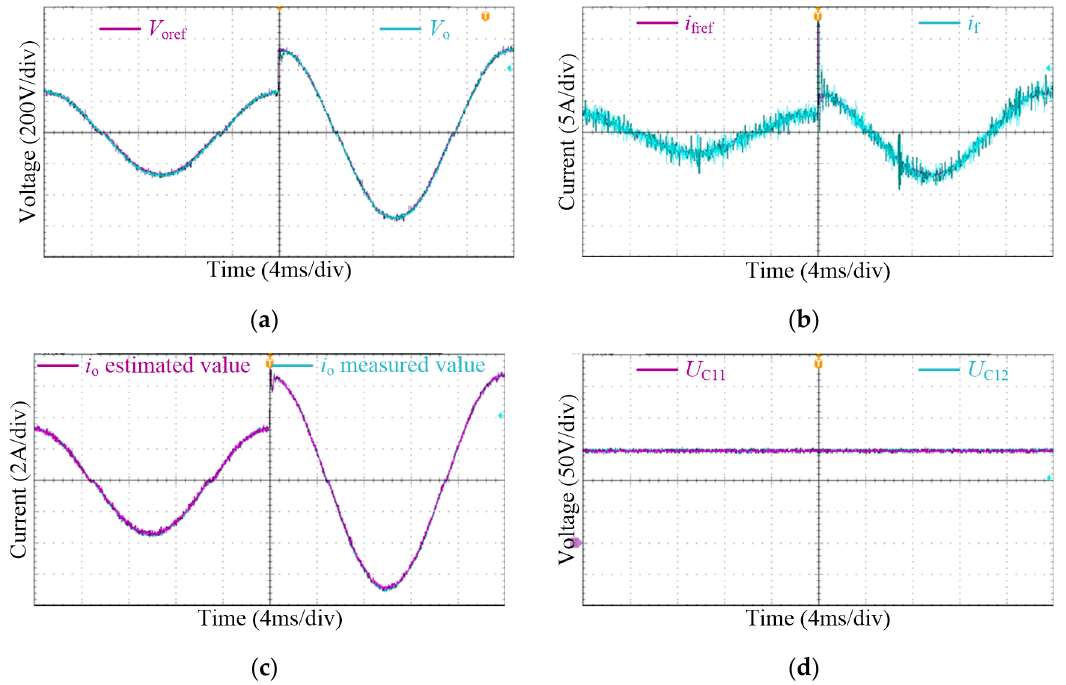
Figure 9. Dynamic state experimental results: ( a ) Waveforms of V o and V oref . ( b ) Waveforms of i f and i fref . ( c ) Waveforms of the measured value and the estimated value of i o . ( d ) Waveforms of capacitor voltages.